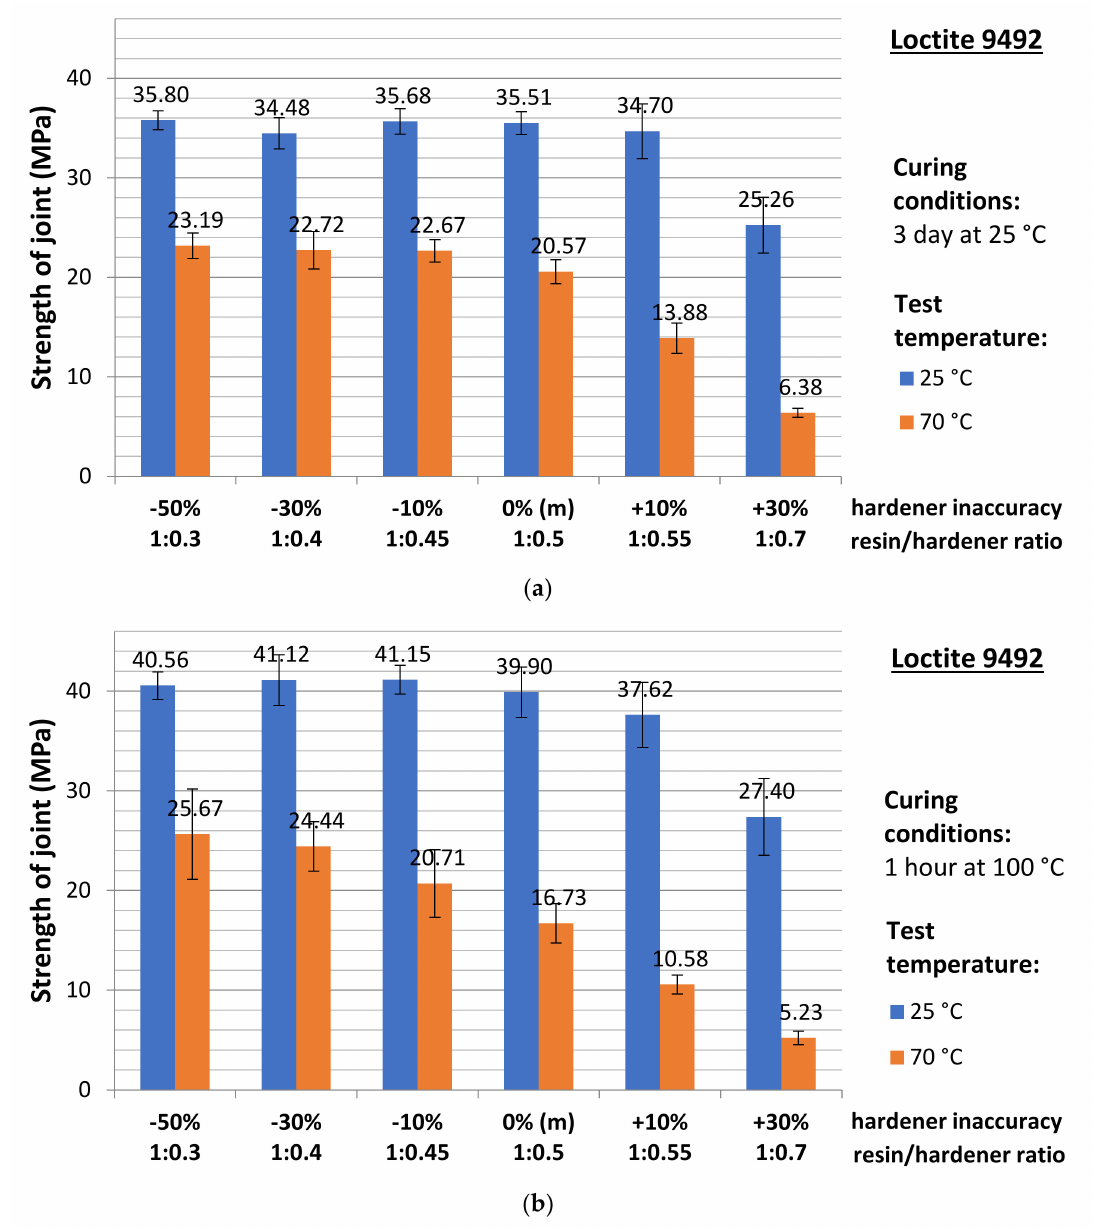
Figure 8. Change in the adhesive joint strength from the test temperature for the joints ( a ) cured without heat holding and ( b ) cured with heat